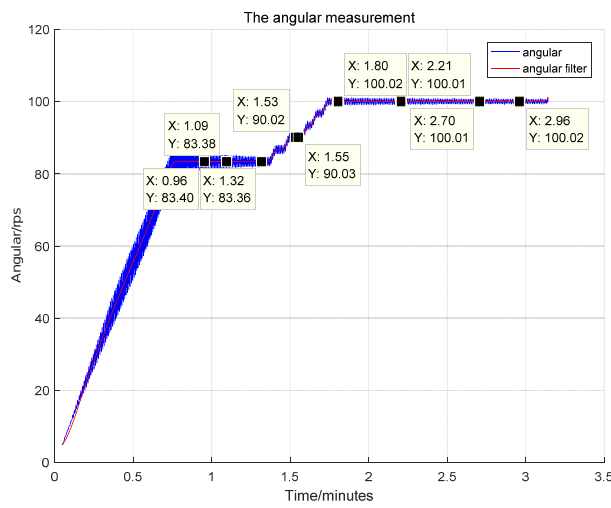
Figure 10. Instantaneous single ‐ axle angular speed output by the magnetic sensor electronic solver module.